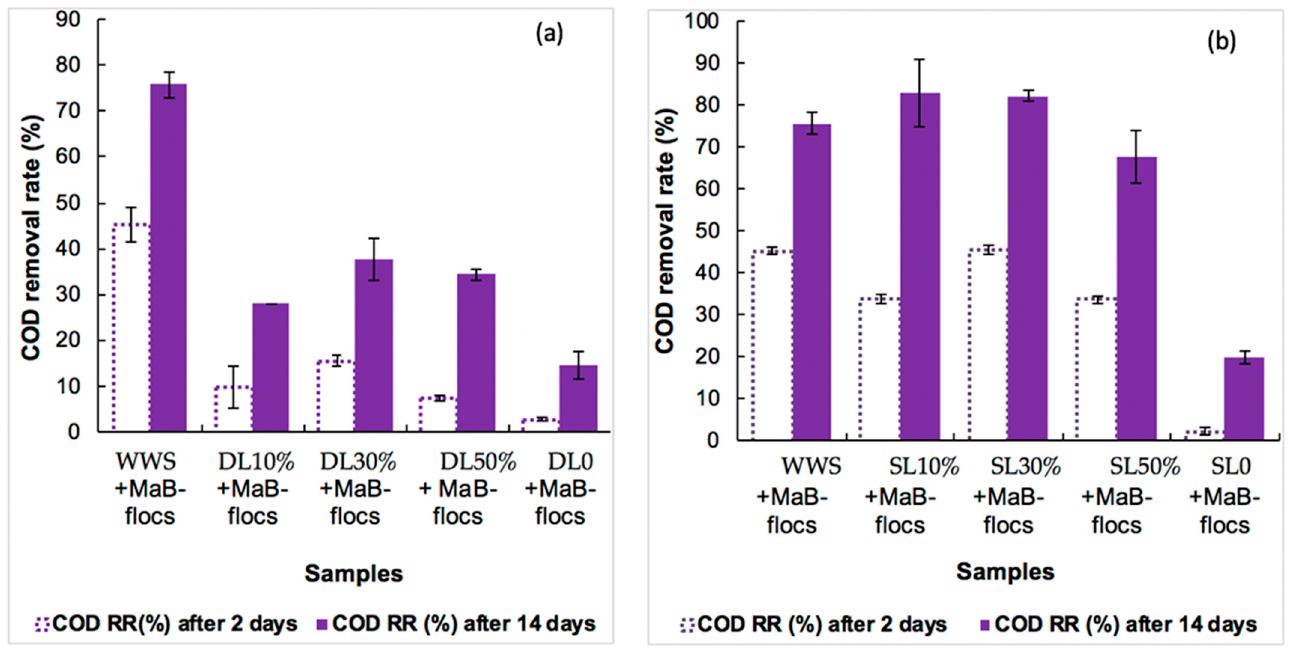
Figure 2. COD removal rates (mean value ± SD) evaluated after 2 and 14 days of Ma-B flocs culture for each diluted substrate. ( a ) DL: Liquid Digestate; ( b ) SL: Liquid Slurry. WWS is synthetic wastewater control.